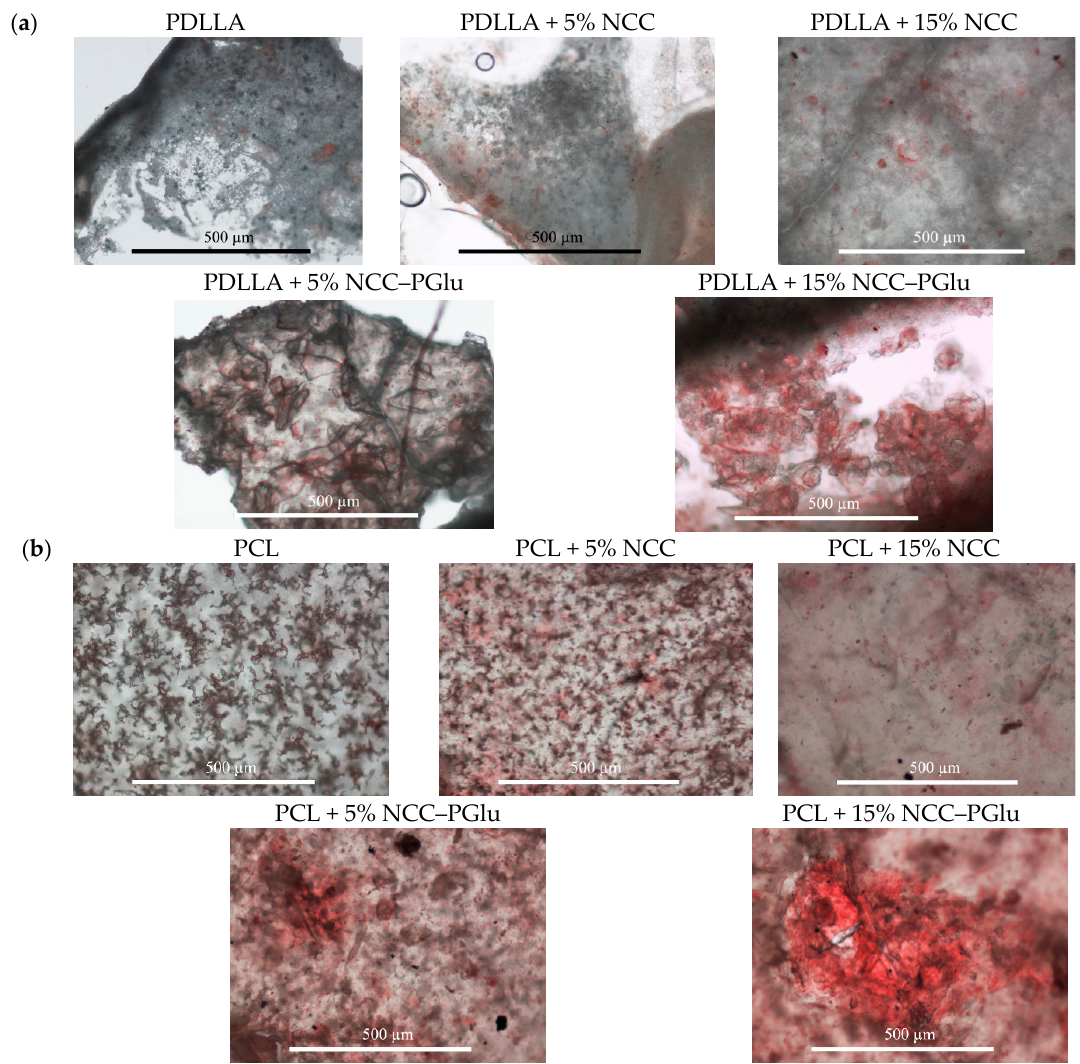
Figure 6. In vitro mineralization study of the pure PDLLA ( a ) and PCL ( b ) materials and their composites with original and modified NCC. The mineralization study was performed by alizarin red S assay. The intensity of the red color corresponds to the amount of calcium ions on the surface of the films.